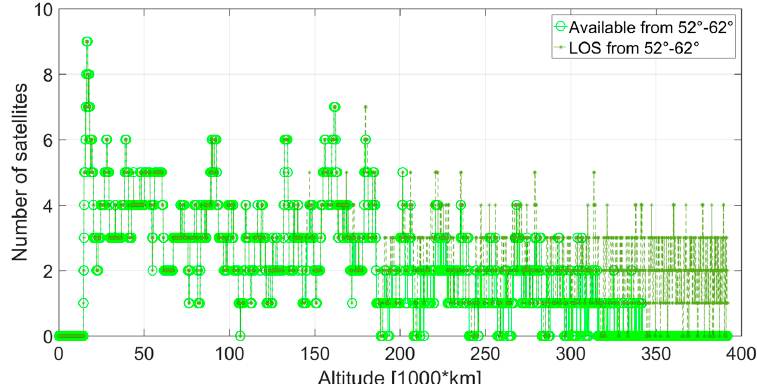
Figure 40. Visible satellites (in the line of sight (LOS)) and available satellites at the receiver’s position, for which the corresponding signal is transmitted at an angle between 52° and 62° from the transmitter’s boresight.